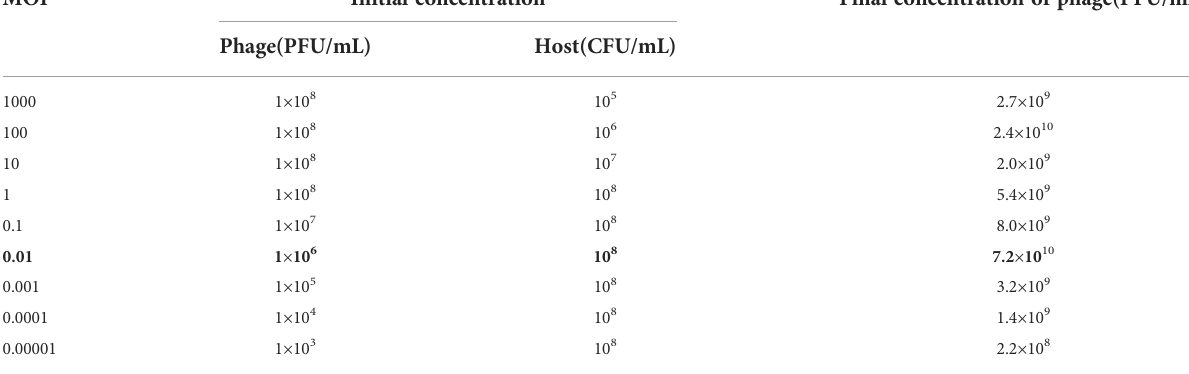
TABLE 1 Multiplicity of infection of phage